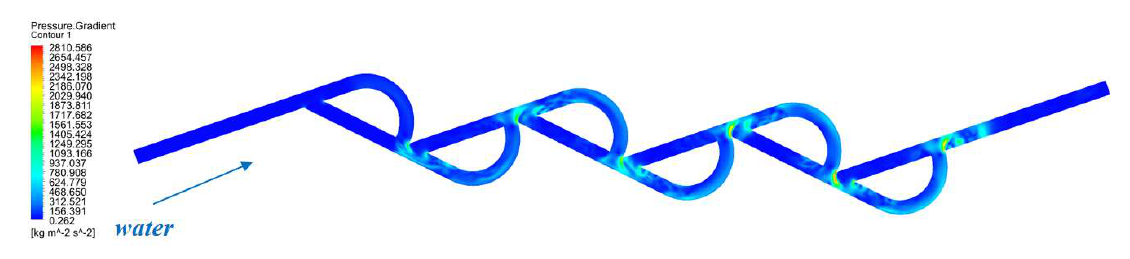
Figure 14. Cloud diagram of pressure distribution .